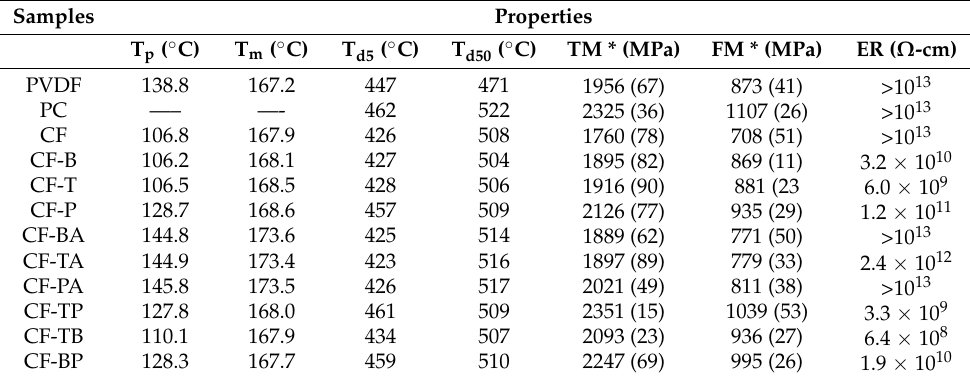
Figure 4. DSC cooling curves of ( a ) 5 °C/min and ( b ) 40 °C/min cooled samples. Table 1. Representative physical properties of the samples.